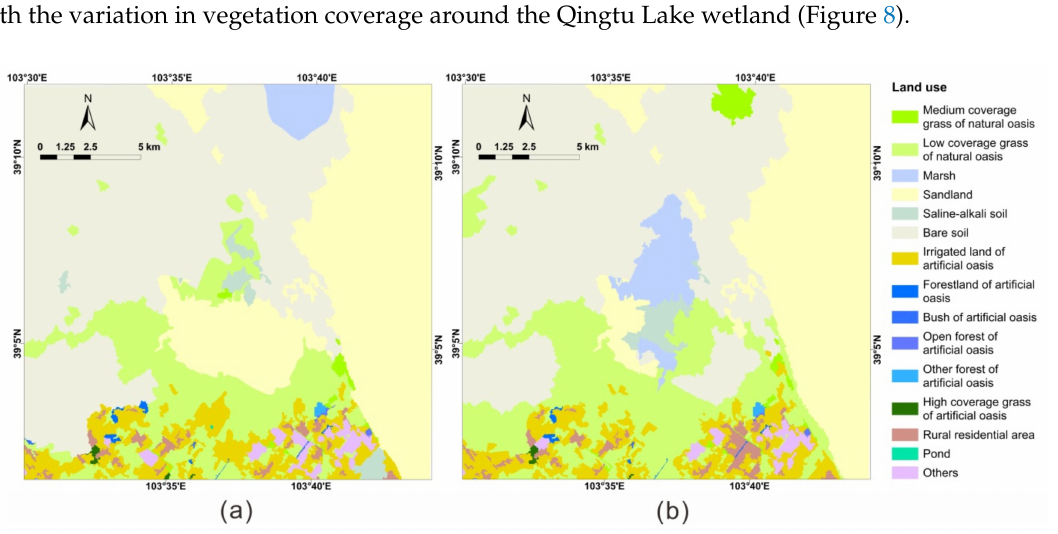
Figure 9. Variation of land use from 1970 ( a ) to 2017 ( b